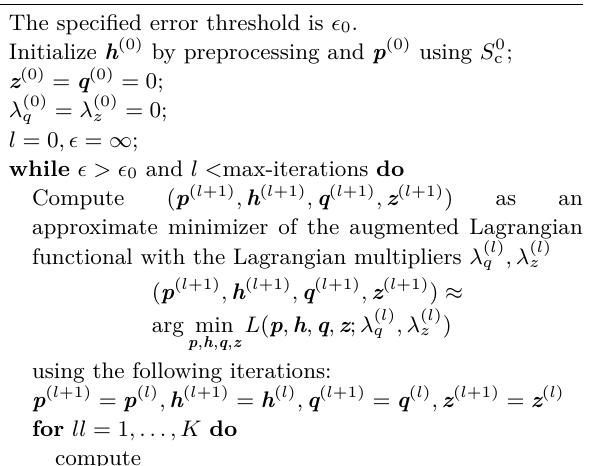
Algorithm 1 Algorithm for subdivision surface